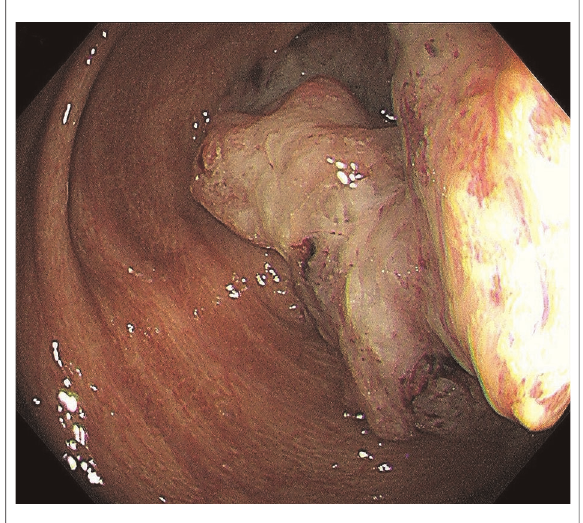
FIGURE 2 In the ileocecal region, a circumferential, irregular, ulcerative mass was found.